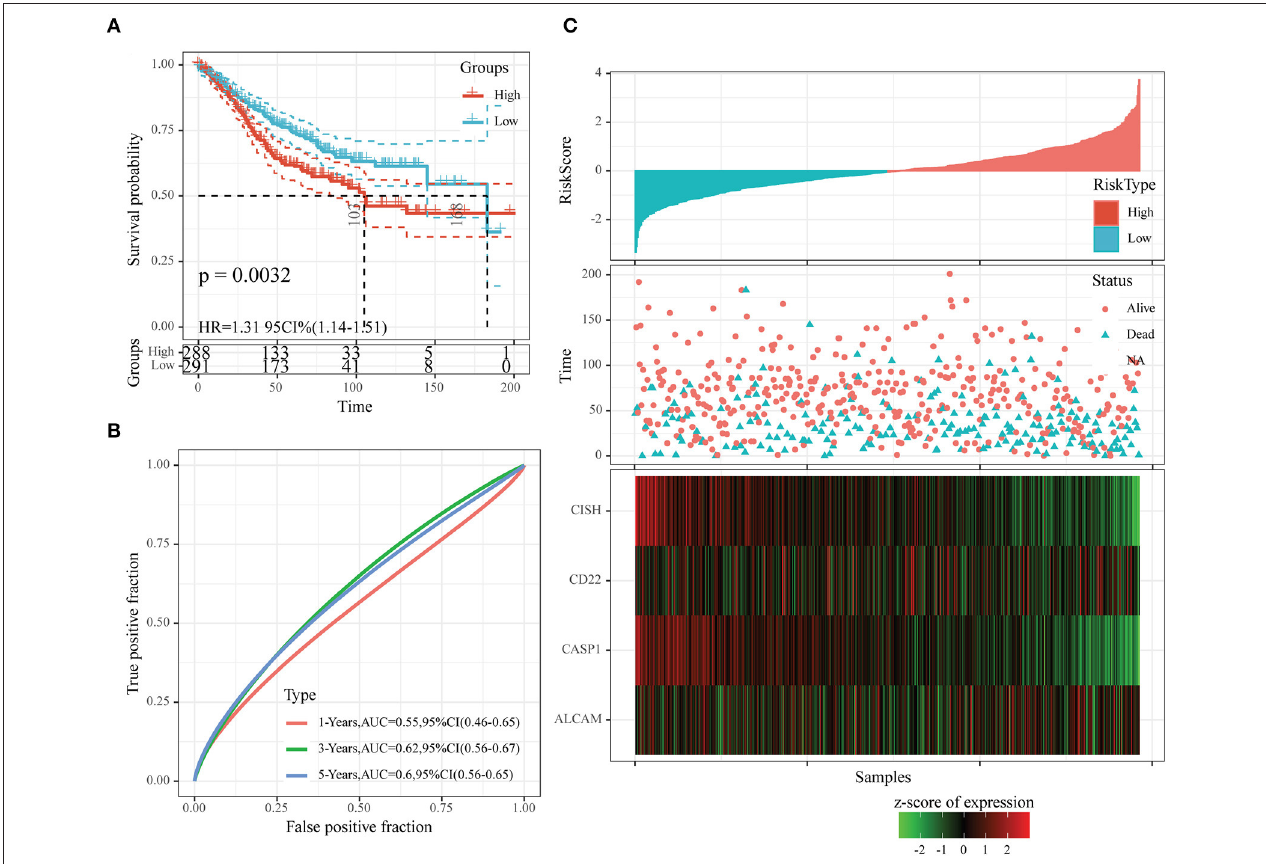
FIGURE 8 | The classification effect of the four-oxaliplatin resistance-related gene-based prognosis signature in the second test set (GSE39582). (A) Analyzed the prognostic difference after predicted classification according to the four-gene signature in the second test set (GSE39582). (B) Receiver operating characteristic (ROC) curves of the four-gene signature in colon cancer samples in the second test set (GSE39582). (C) The relationship of risk score, survival time, and survival status with the expression levels of the four genes in the second test set (GSE39582).